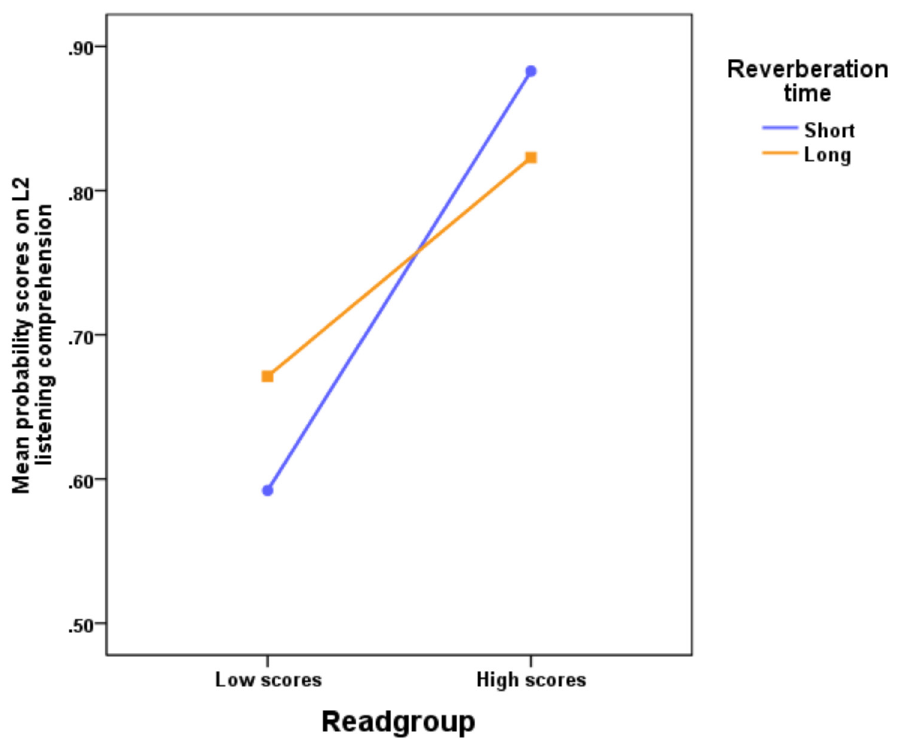
Fig 2. Mean probability scores on L2 listening comprehension for participants with different second- language abilities. Interaction between Swedish speaking participants ’ scores on a second-language (English) reading comprehension test (readgroup divided in low and high scores, split by the median) in a classroom with a short reverberation time (0.33 sec) and a classroom with long reverberation time (1.07 sec).